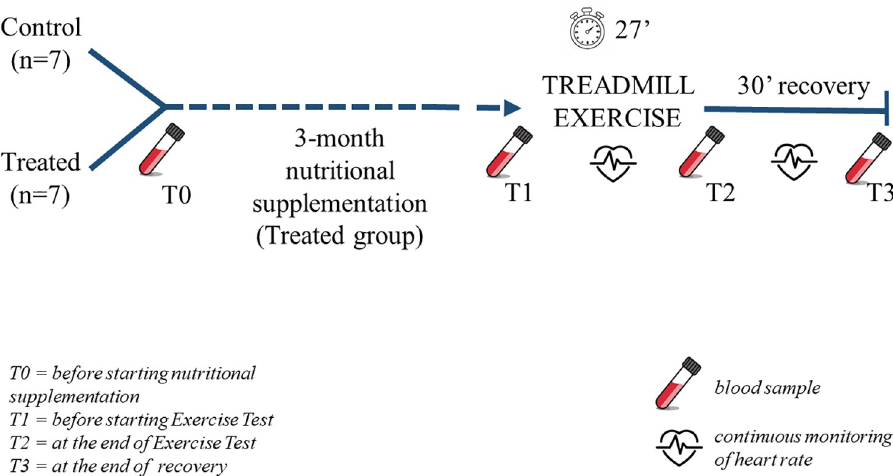
Fig 1. Experimental protocol. Fourteen dogs were randomly divided into two groups: a Control (n = 7) and a Treatment (n = 7) group. The dogs in the Treatment group were fed a dry diet with dietary supplementation for 3 months. At the end of this period, all of the dogs underwent a standardized submaximal treadmill Test conducted at four walking speeds and inclinations. Heart rate was monitored throughout the duration of the test (27 min) and recovery period (30 min). Blood samples were taken before starting the nutritional supplementation treatment (T0), immediately before starting the Exercise Test (T1), within the first 2 minutes after exercise test termination (T2) and at the end of the passive recovery period